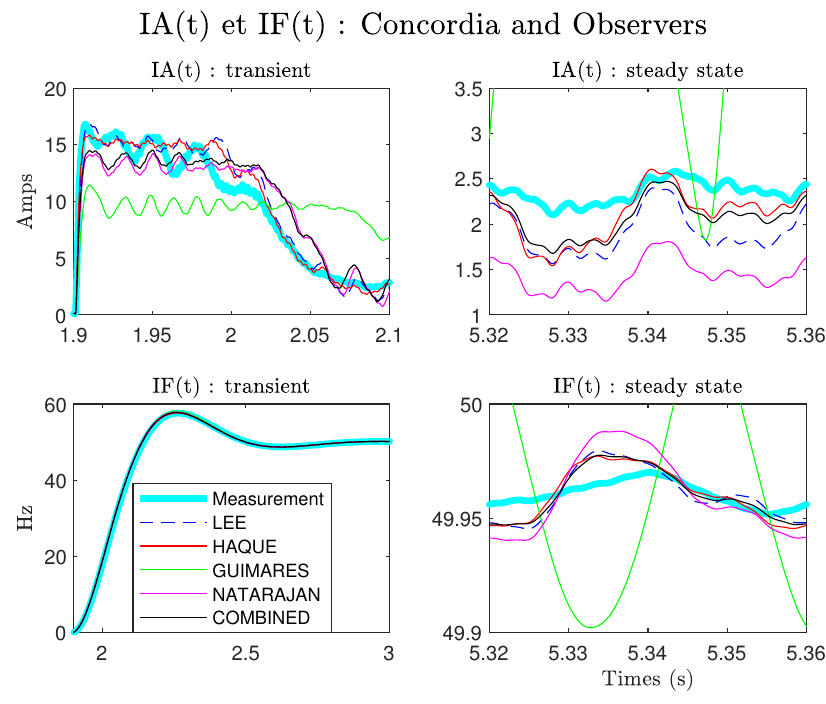
Figure 5. Comparison between models: IA(t) et IF(t), K i = 10,000, K p = 0, G =